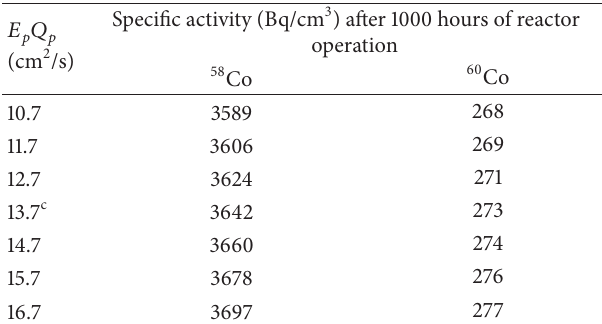
Table 6: Specific activity of 58 Co and 60 Co in primary coolant of PWR with different values of 𝐸 𝑃 𝑄 𝑃 .